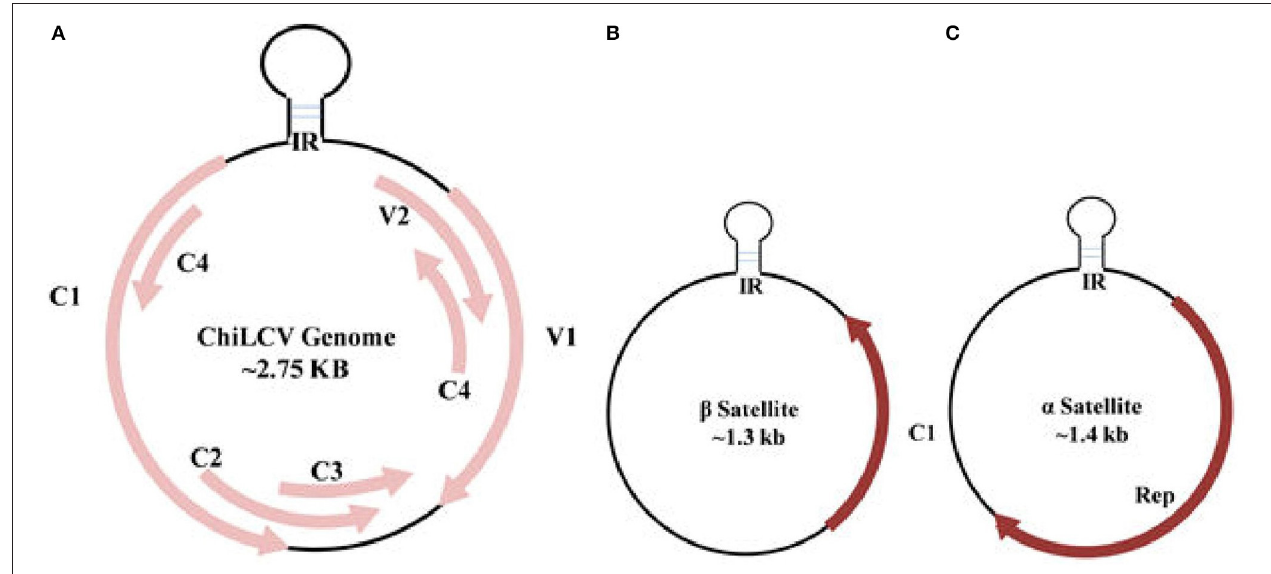
FIGURE 3 | Genome organization of Chili leaf curl virus (ChiLCV) (A) and associated β and α satellites (B,C) . IR, intergenic region; Rep, replication initiator protein.